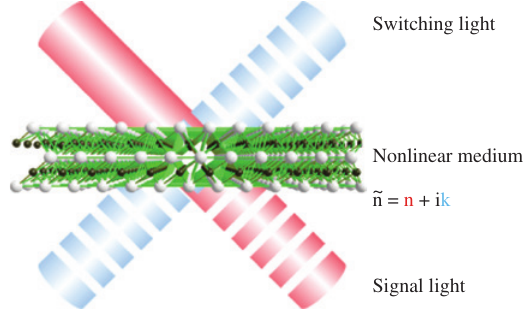
Figure 2: Schematic diagram of all-optical modulation. Signal light is controlled and modulated by another switching light beam. The light-light interaction is realized through nonlinear medium, and the core of the all-optical modulation is to either control or modulate the real or imaginary parts of the refractive index of the